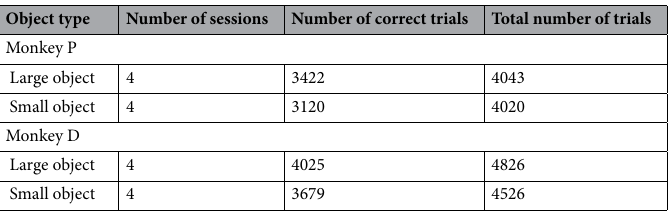
Table 1. Total number of sessions and correct trials collected during the baseline experiment.